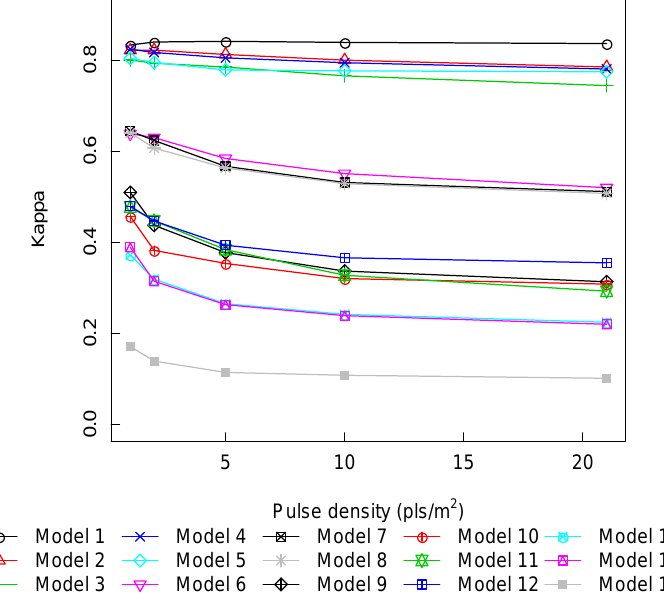
Figure 4. Classification accuracy (kappa) for all random forest models (Table 5) at each of the tested pulse densities.